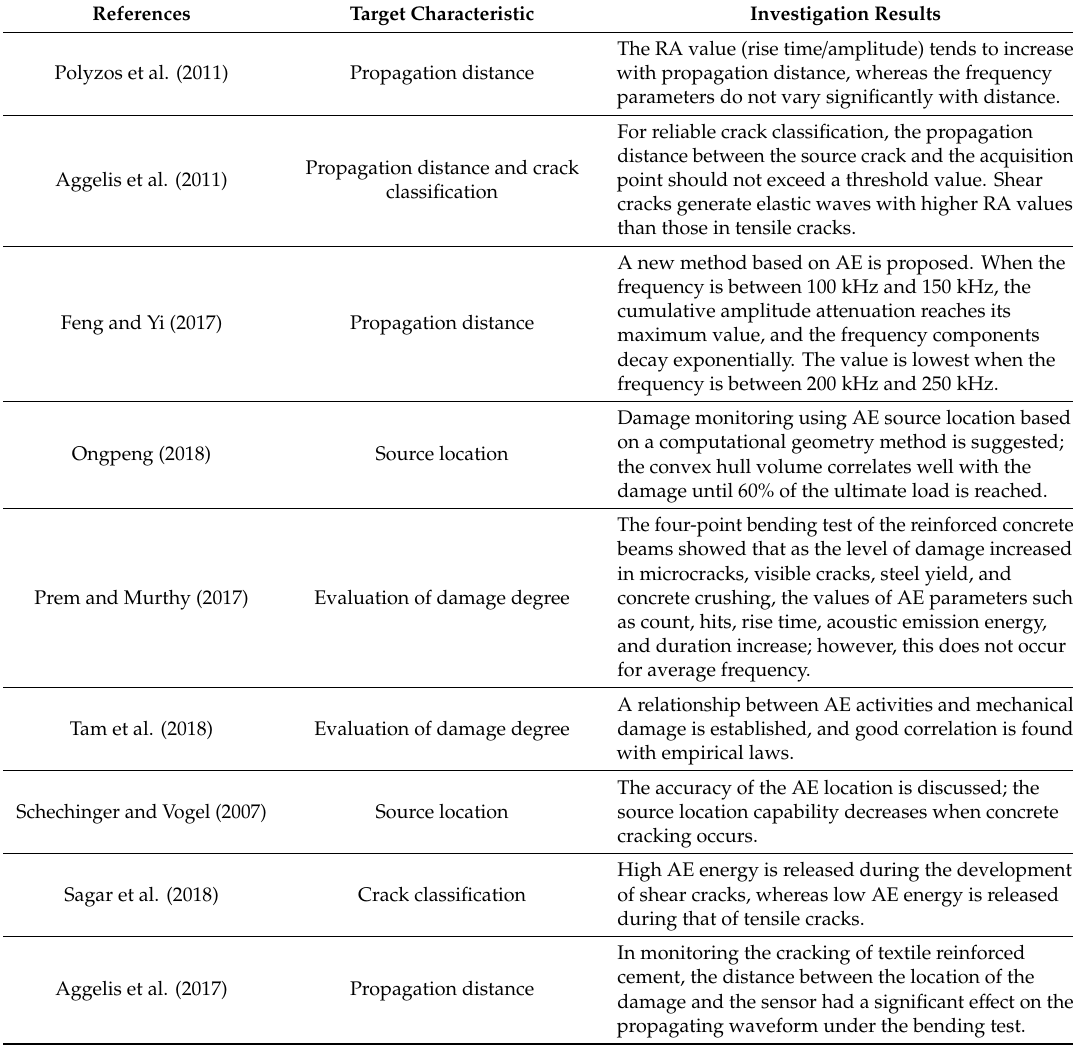
Literature review of investigations of acoustic emission (AE) characteristics in concrete